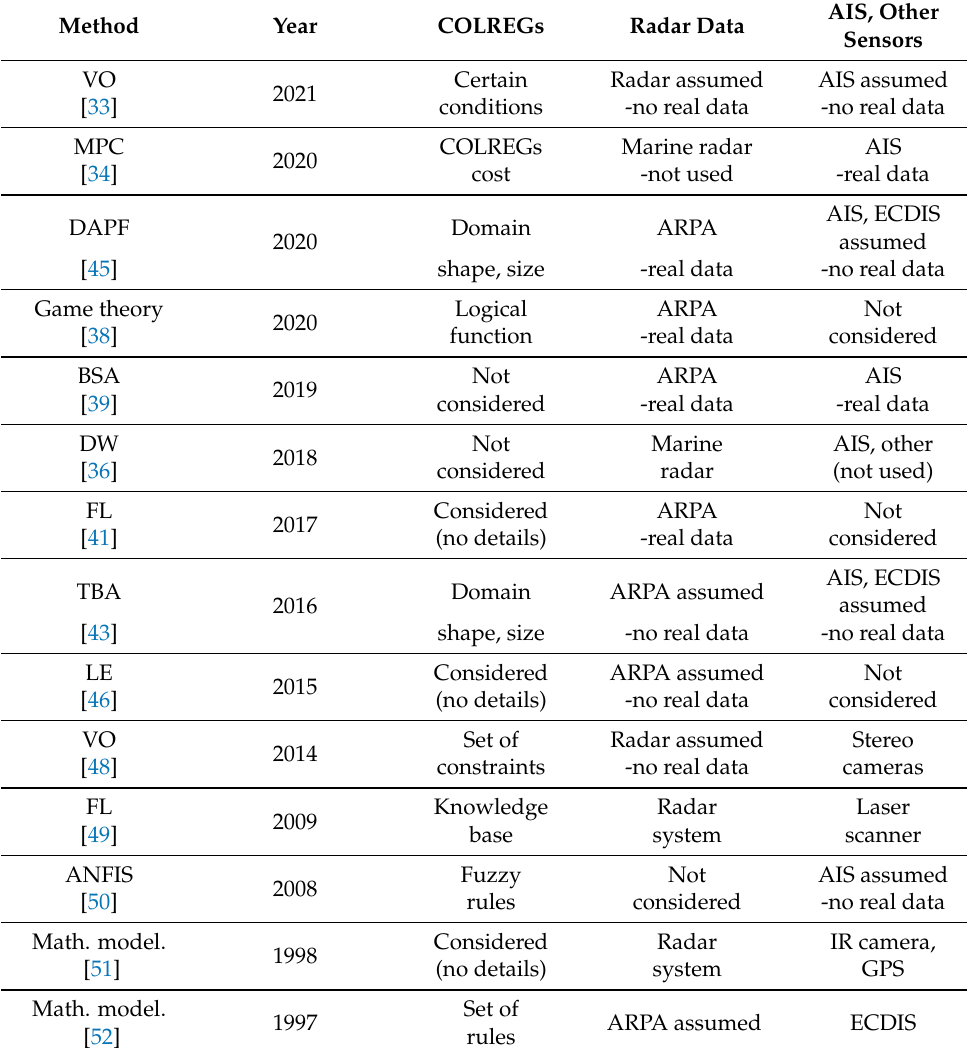
Table 4. A comparison of deterministic methods applying radar remote sensing and other sensors— part 2.